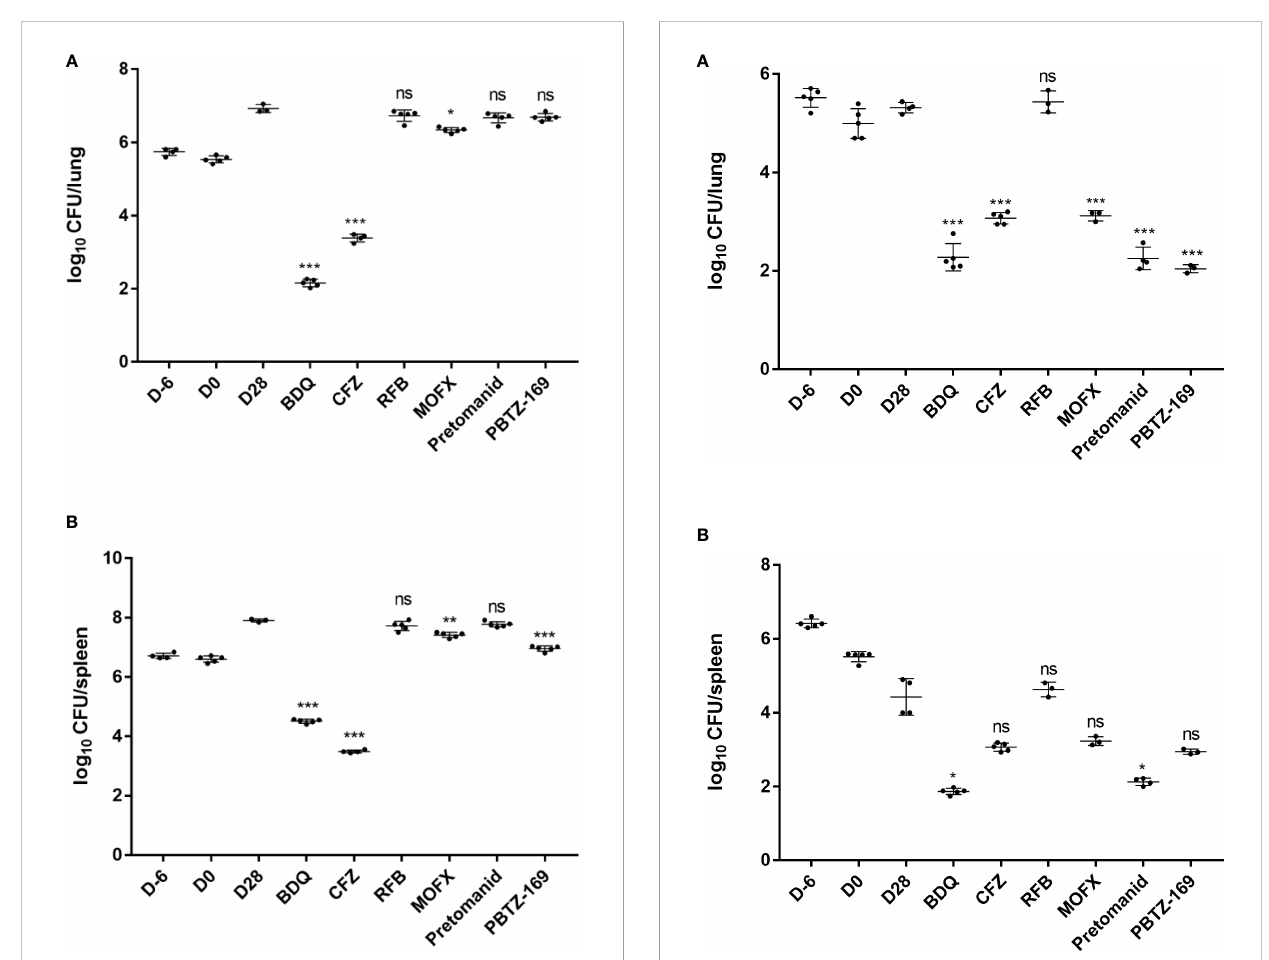
FIGURE 2 Mean number (log 10 ) of CFU per lung (A) and spleen (B) in various groups of mice infected with M. avium . Two mice failed to infect due to operational reasons, bacteria did not enter the tail vein, showing thickened tail redness and swelling, and mice weighed signi fi cantly higher than other members of this group (one each from CMC and CFZ group). One mouse from CMC group died during the treatment period. D-6 represents the day after infection, D0 represents the start of drug treatment in mice, and D28 represents twenty-eight days after drug treatment in mice. *P <0.05; **P <0.01; ***P <0.001; “ ns ” indicates no statistically signi fi cant difference between the two groups.